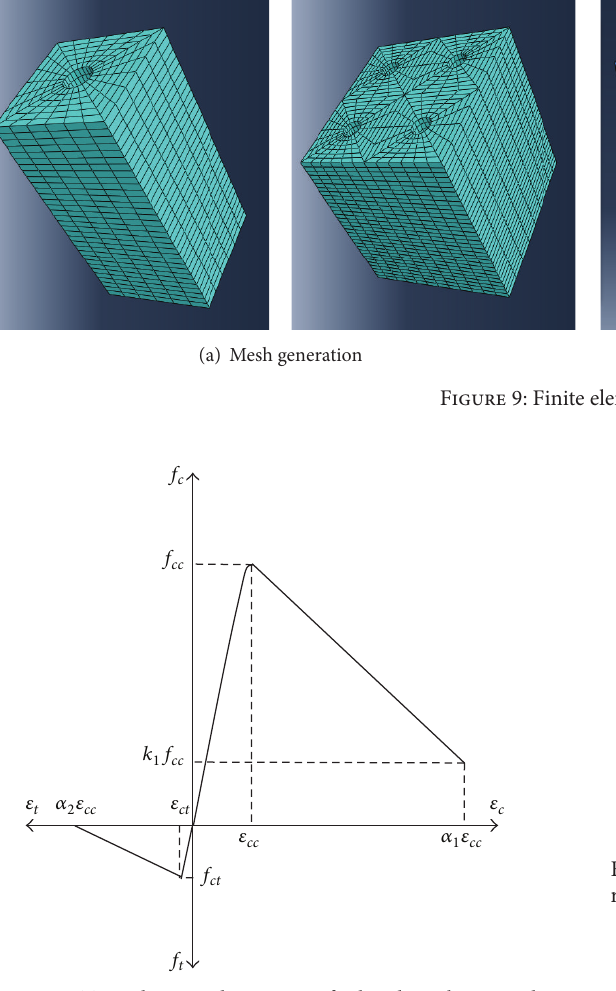
tension strength ( 𝑓 𝑐𝑡 ) and ultimate compression strength ( 𝑓 𝑐𝑐 ) are taken as 14 MPa and 135 MPa, respectively, deter- mined from the experimental field tests. The uniaxial strain